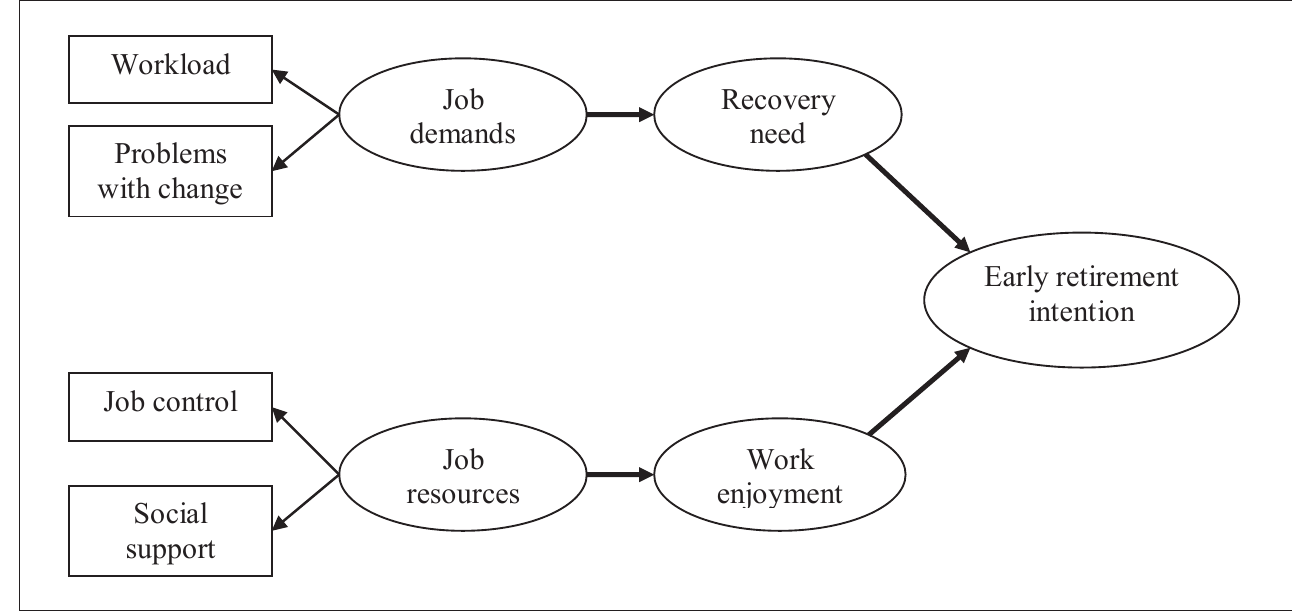
FIGURE 1: The job demands-resources model applied to early retirement intention.